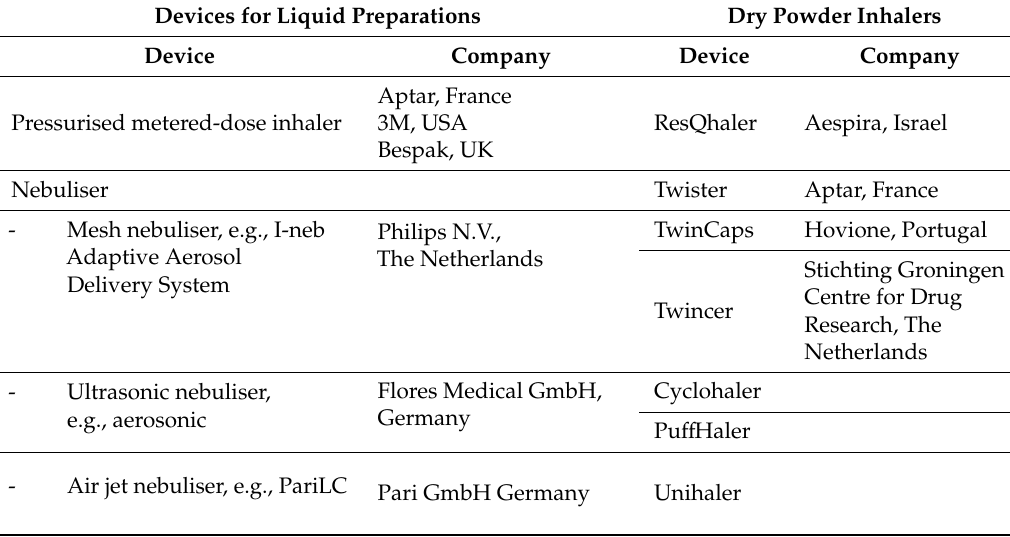
Table 6. Examples of devices for pulmonary administration